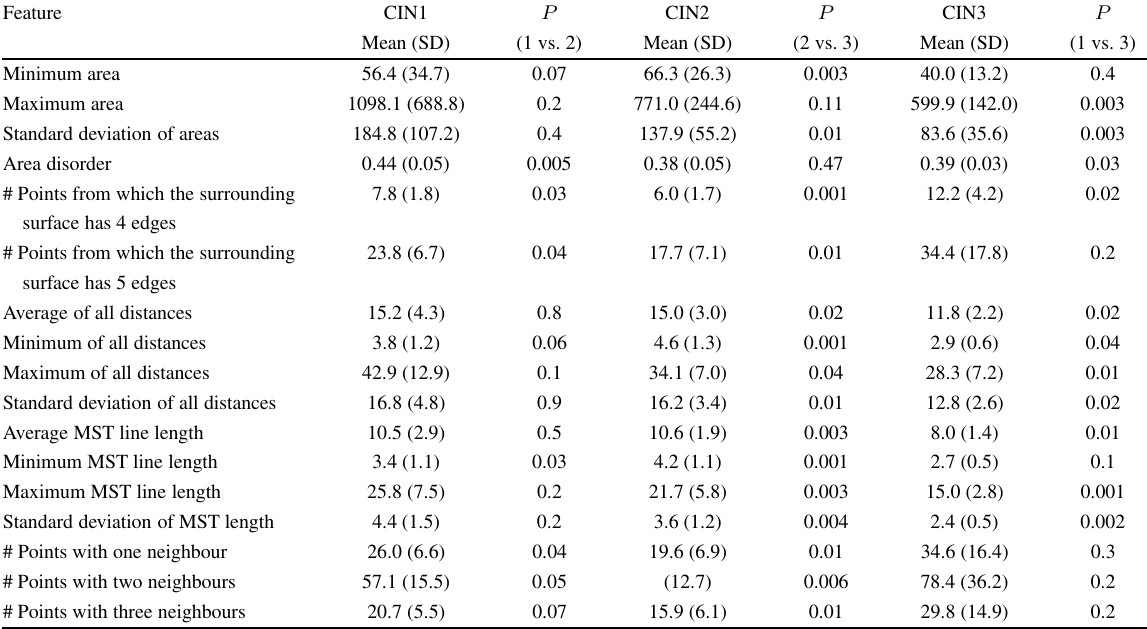
Correlation table of high-risk human papillomavirus (HPV) posi- tive and negative consensus cervical intraepithelial neoplasia